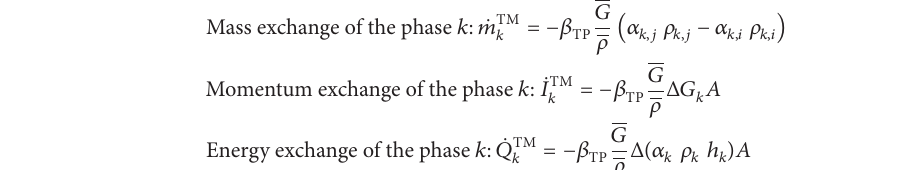
Table 2: CTF models for turbulent mixing and void